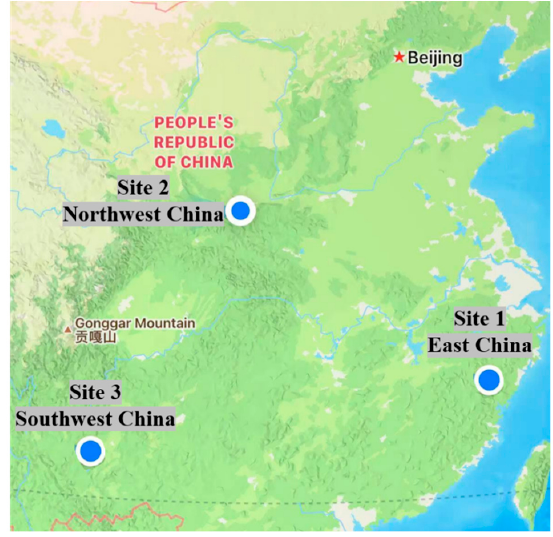
Figure 1. Geographical location of the surveyed expressway.